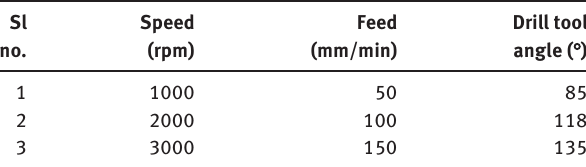
Table 2 Summary of parameters considered for